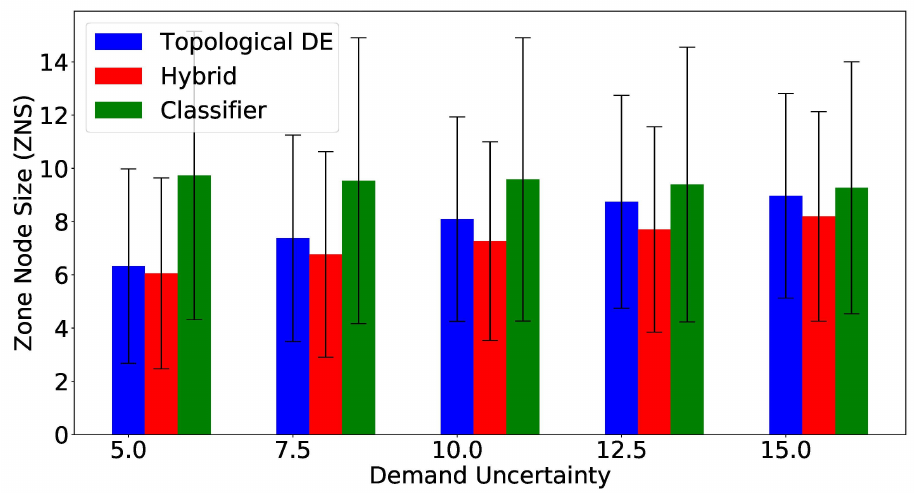
Figure 6. Comparing Zone Size in Number of Nodes.